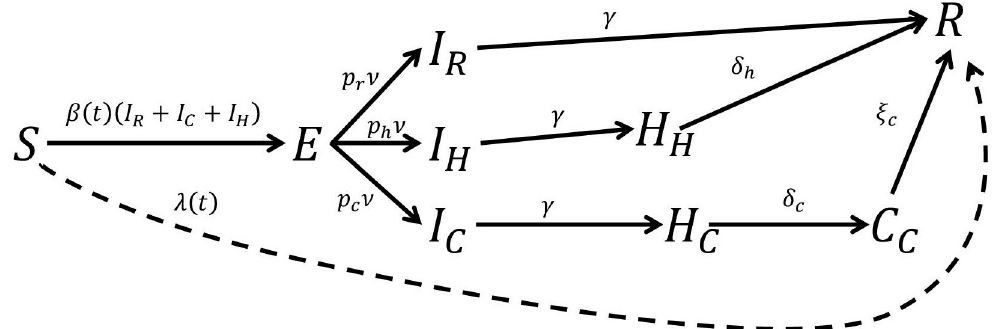
Fig 14. Two COVID-19 compartmental models for disease policies based on physical distancing measures. The solid lines show the model first presented in [30], where the coefficients connecting the compartments are interpreted couplings, population fractions, time delays and so forth. The addition of the dotted line connecting the ‘susceptible’ and ‘recovered’ compartments creates another model where a vaccination campaign is taken into account.